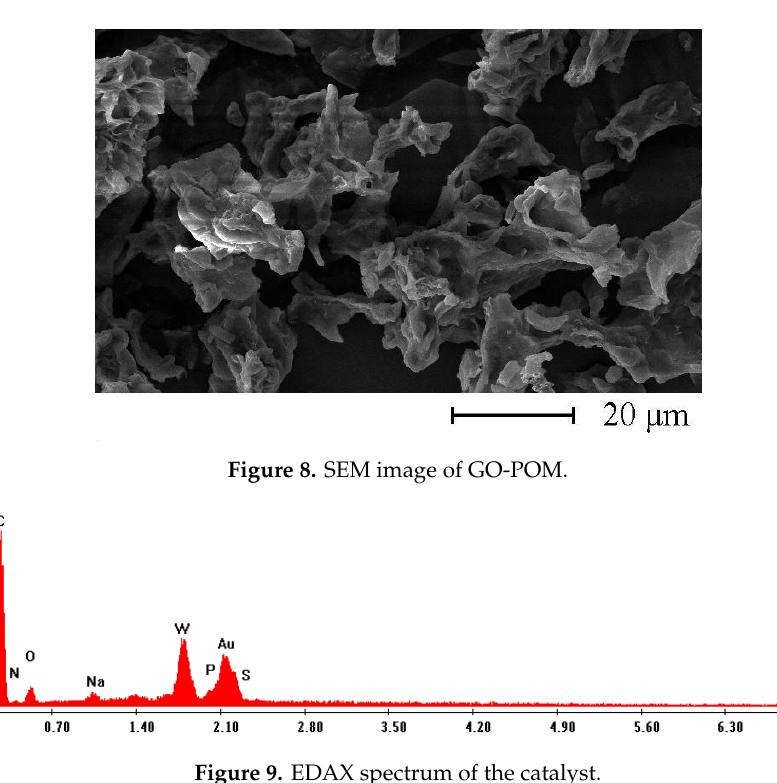
Figure 9. EDAX spectrum of the catalyst.